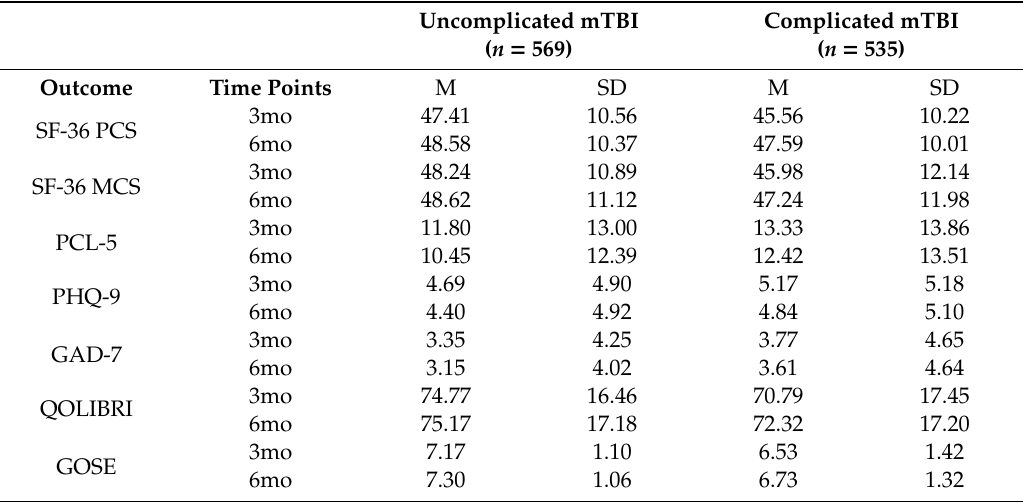
Table A1. Descriptive statistics on outcomes by uncomplicated and complicated mTBI